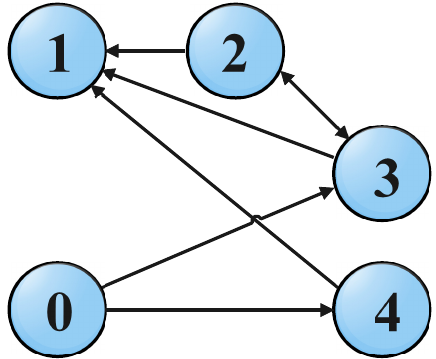
Figure 1. Topology of the system network of one leader and four